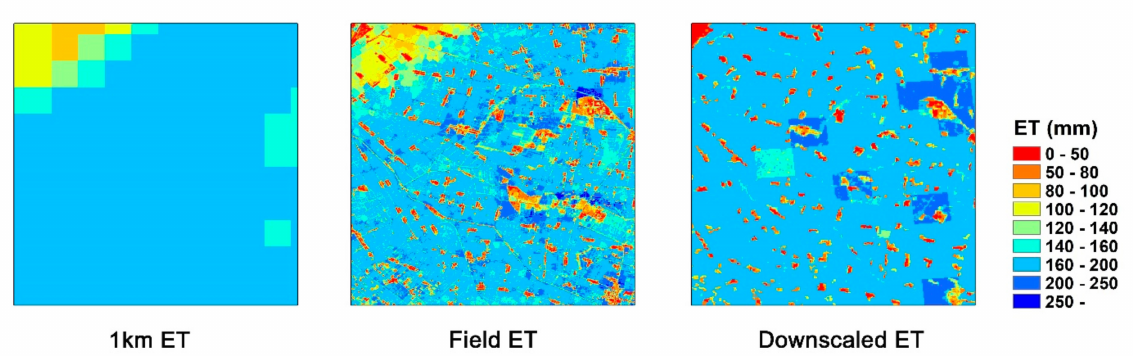
Figure 9. The spatial distribution comparison of monthly fine-resolution ET data with the surface resistance (rs)-based downscaling ET method [21] in July. The 1-km ET data are calculated with the ETWatch model, and the field ET is derived with the allocation method from this research. The downscaled ET is based on the surface resistance downscaling